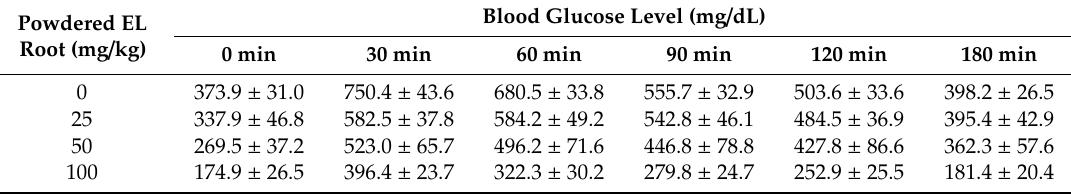
Table 3. Effects of powdered E. longifolia root in an Oral Glucose Tolerance Test (OGTT) in db/db mice.